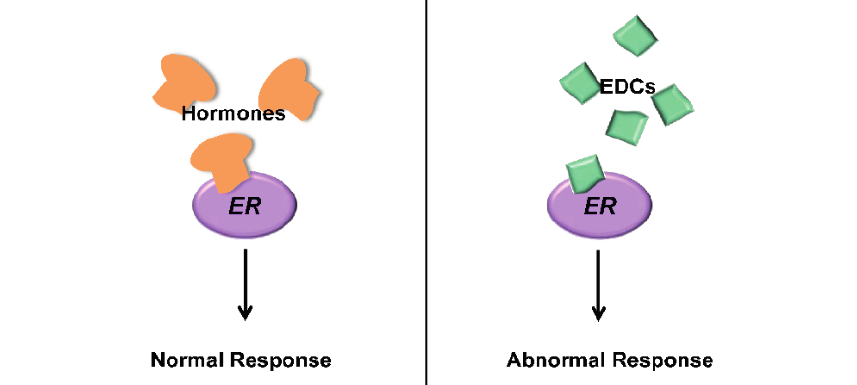
Figure 1 . Estrogen Receptor protein (ER) regulate gene expression after binding hormones, schematically shown on the left. Endocrine Disrupting Chemicals (right) bind ER and provoke an abnormal physiological response, either inhibiting or untimely activating the normal ER functions. Many diseases are associated with Endocrine Disrupting Chemical